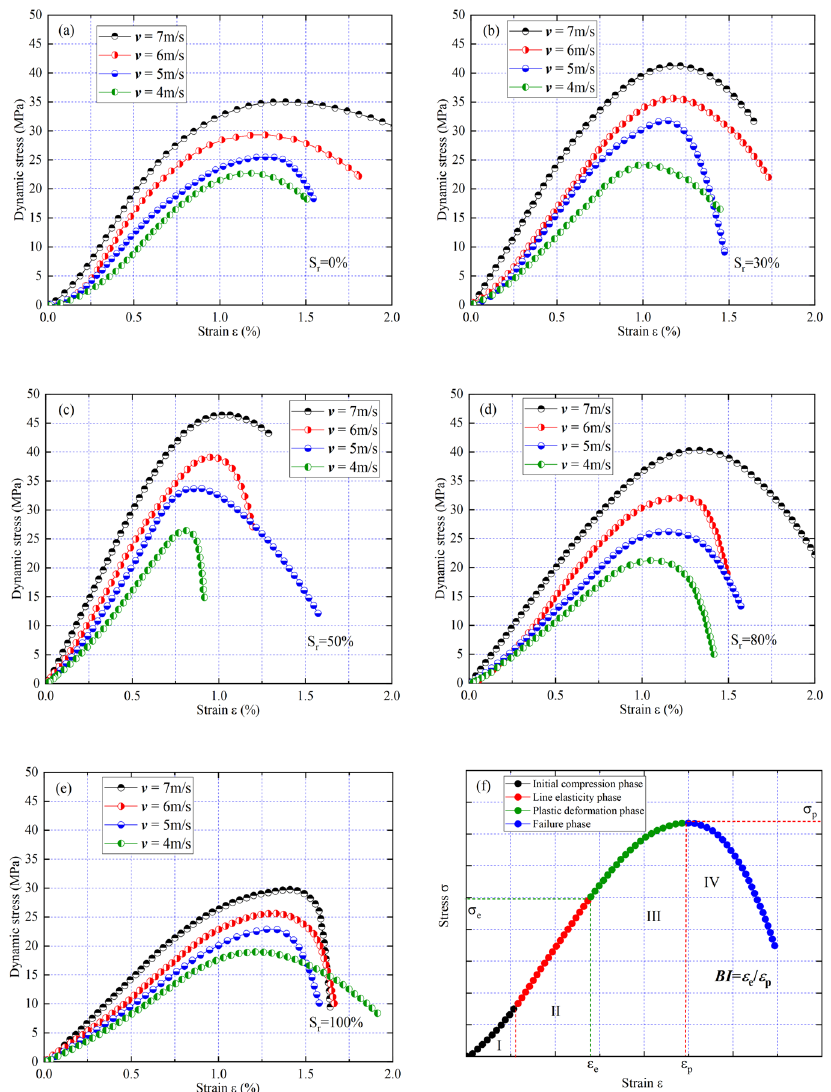
Figure 8. Dynamic stress–strain curves of the sample at low temperatures: ( a – e ) denote samples with saturation of 0%, 30%, 50%, 80%, and 100%, respectively; ( f ) shows the deformation phase divisions of typical stress–strain curves.